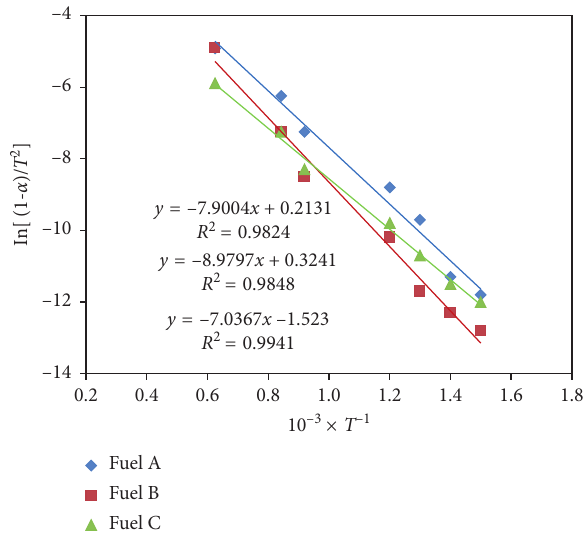
Figure 7: TG curve and fitting equation of particulate matter in O atmosphere.